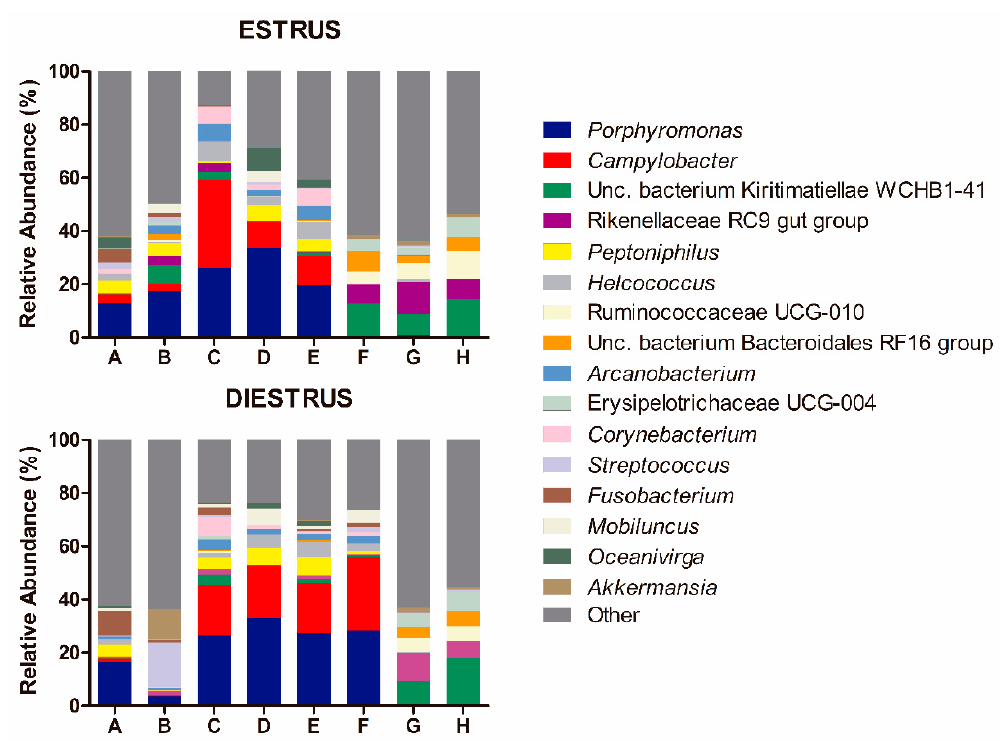
Figure 4. Genus taxonomic relative abundance in individual mares in estrus and diestrus (only taxa with a mean relative abundance > 1.5% at estrus or diestrus are represented). The letters in the x axis correspond to each individual mare. Unc: uncultured bacterium.